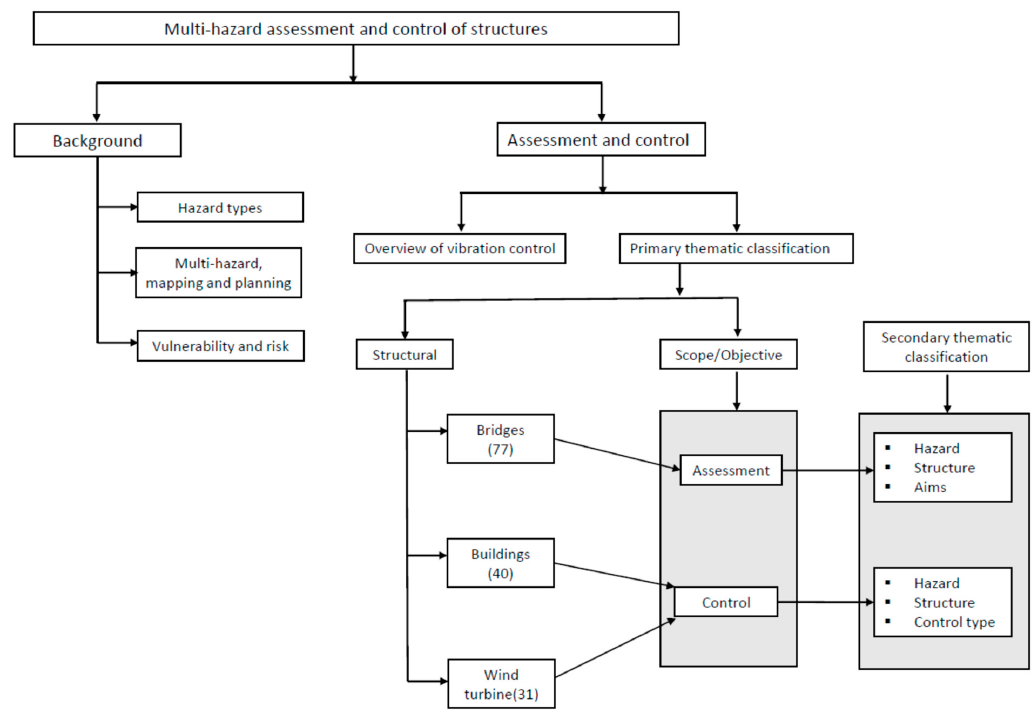
Figure 3. Schematic representation of thematic classification and organization of the paper.